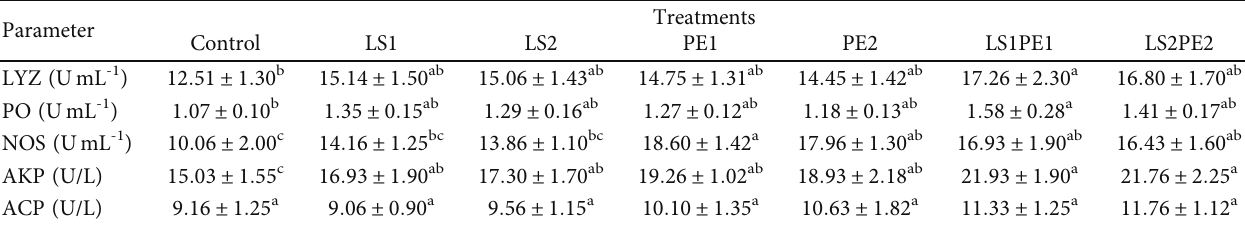
Table 4: Nonspeci fi c immunity responses of narrow-clawed cray fi sh ( Postantacus leptodactylus ) fed with basal diet and supplemented with LS1 ( L. salivarius , 1 × 10 7 CFU/g), LS2 ( L. salivarius , 1 × 10 9 CFU/g), PE1 (Pectin, 5 g/kg), and PE2 (Pectin, 10g/kg), LS1PE1 ( L. salivarius , 1 × 10 7 CFU/g +pectin, 5g/kg) and LS2PE2 ( L. salivarius , 1 × 10 9 CFU/g +pectin, 10 g/kg) for 18 weeks.